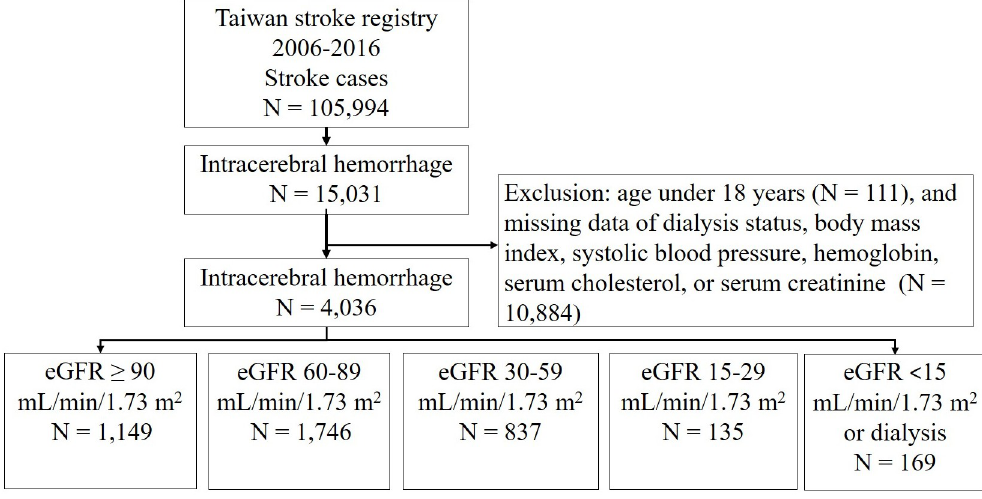
Fig 1. Flow chart for identifying patients with intracerebral hemorrhage by eGFR levels on